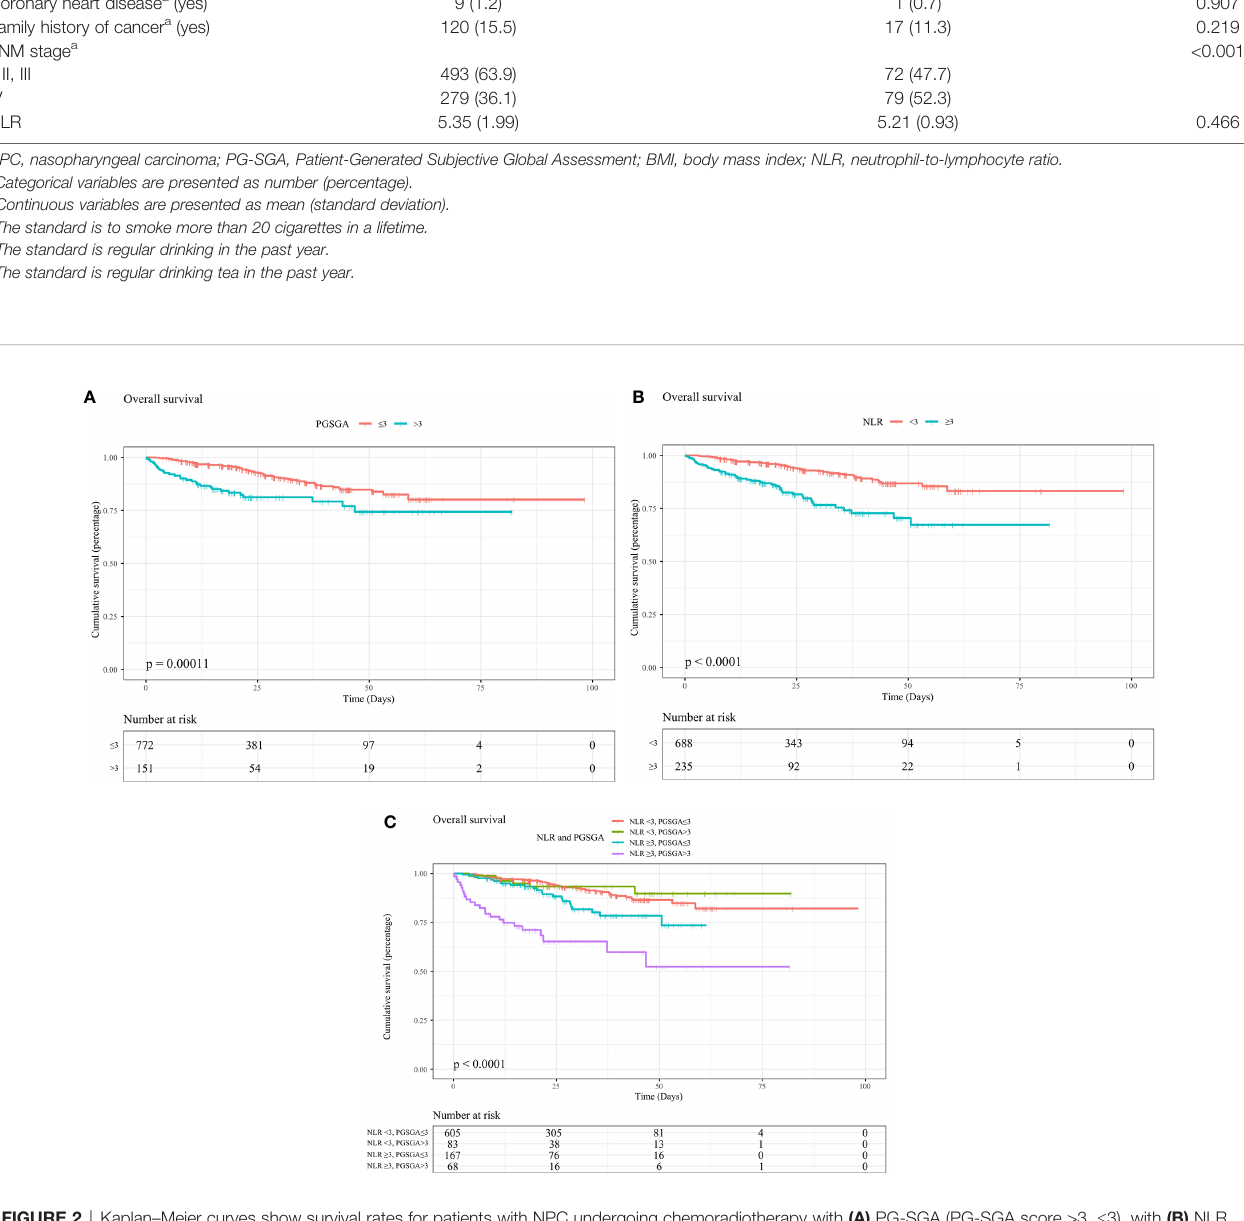
Frontiers in Oncology |